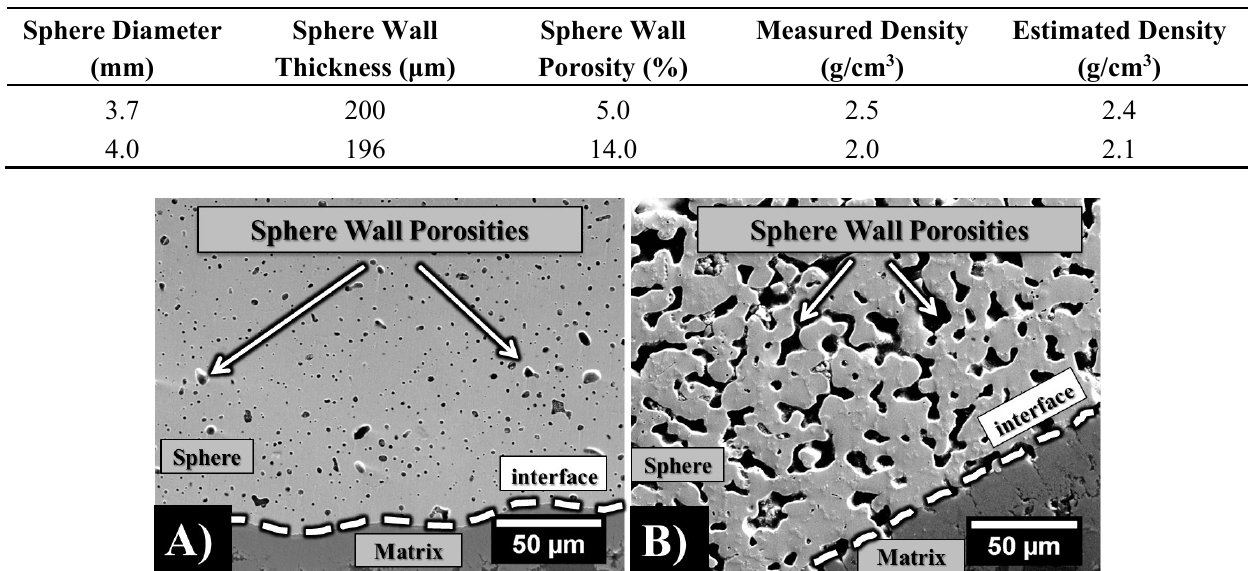
Table 3. Al-S CMF parameters including measured and predicted density.